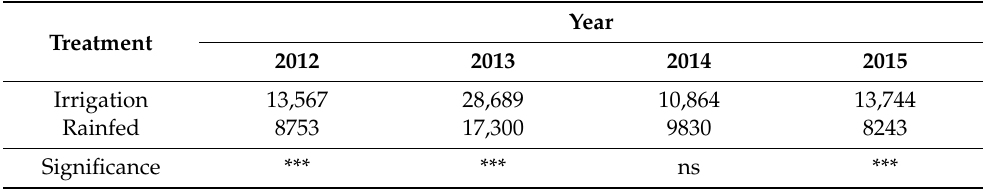
Table 1. Yield in kg ha − 1 for the different irrigation managements during the years of study 2012, 2013, 2014, and